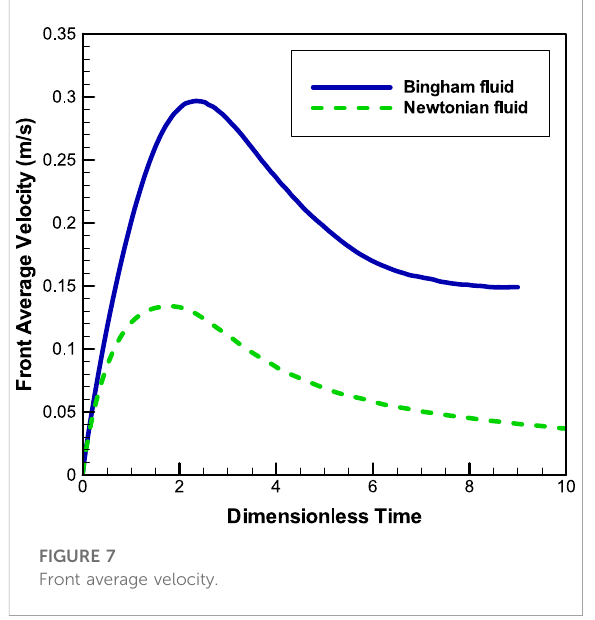
FIGURE 8 Front position of the x